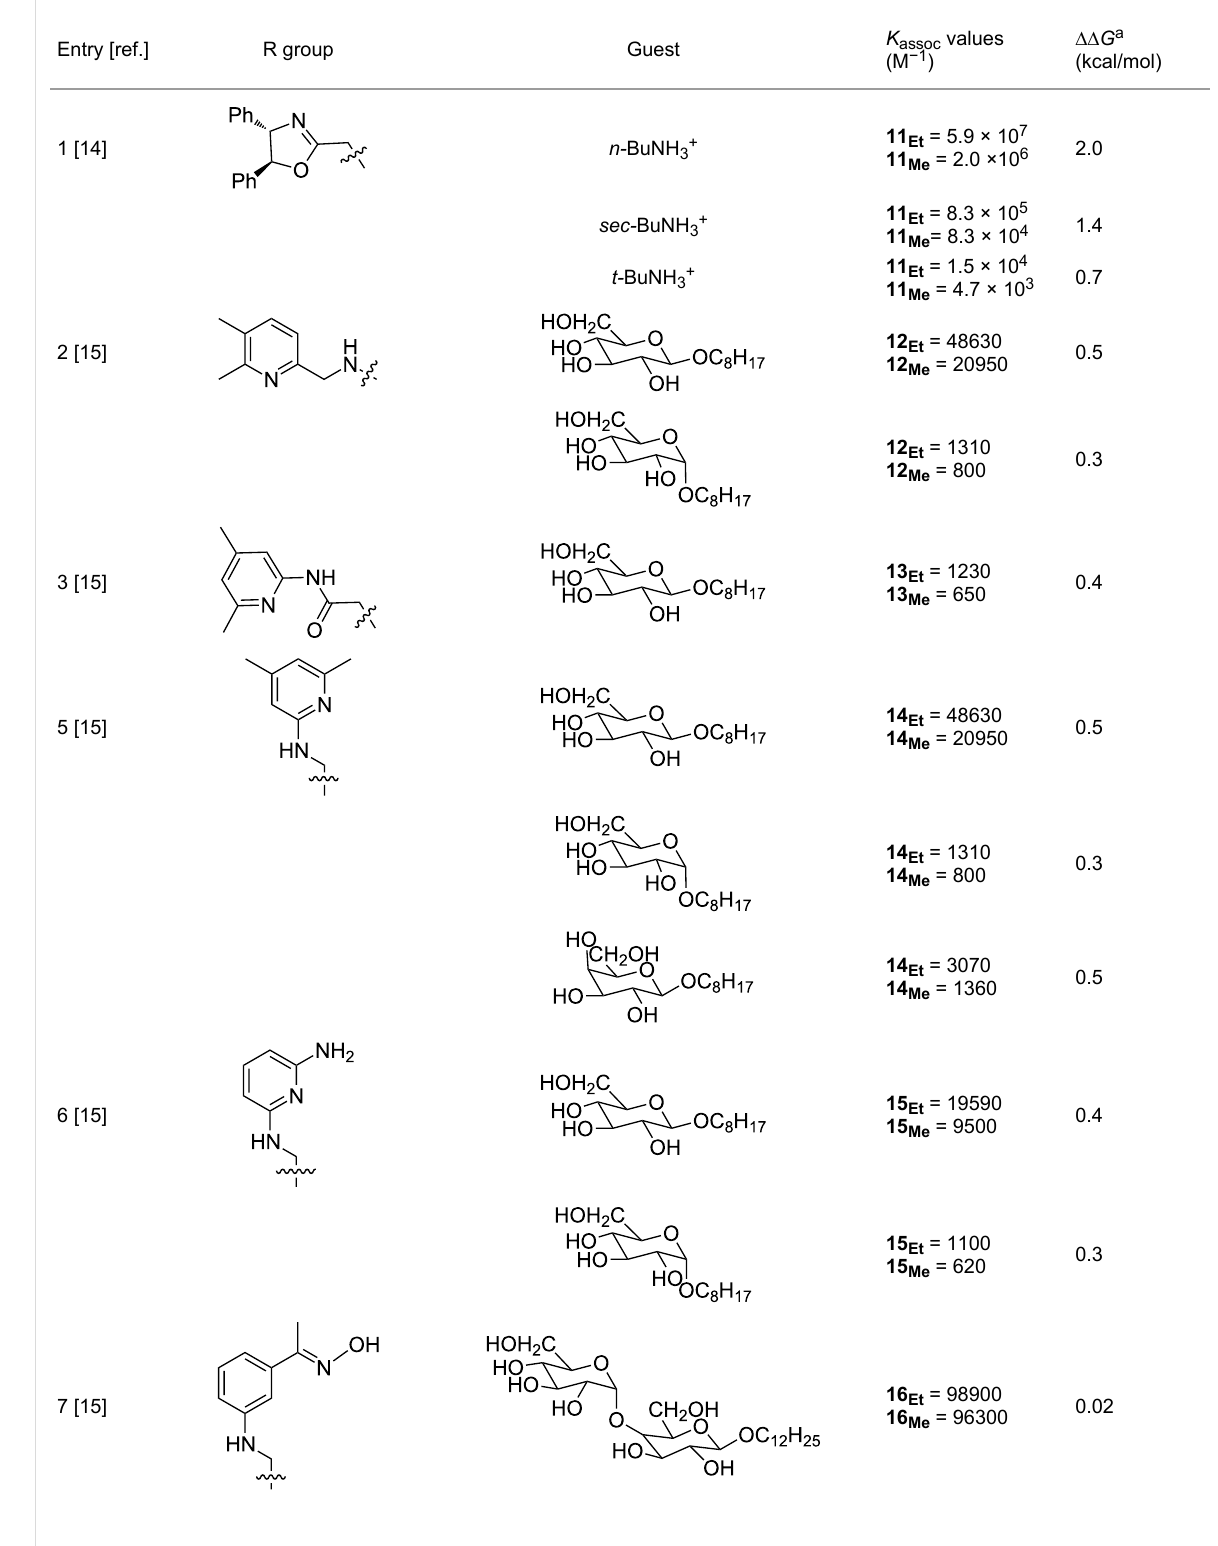
Table 3: Direct affinity comparisons of ethyl- and methyl-substituted hosts.